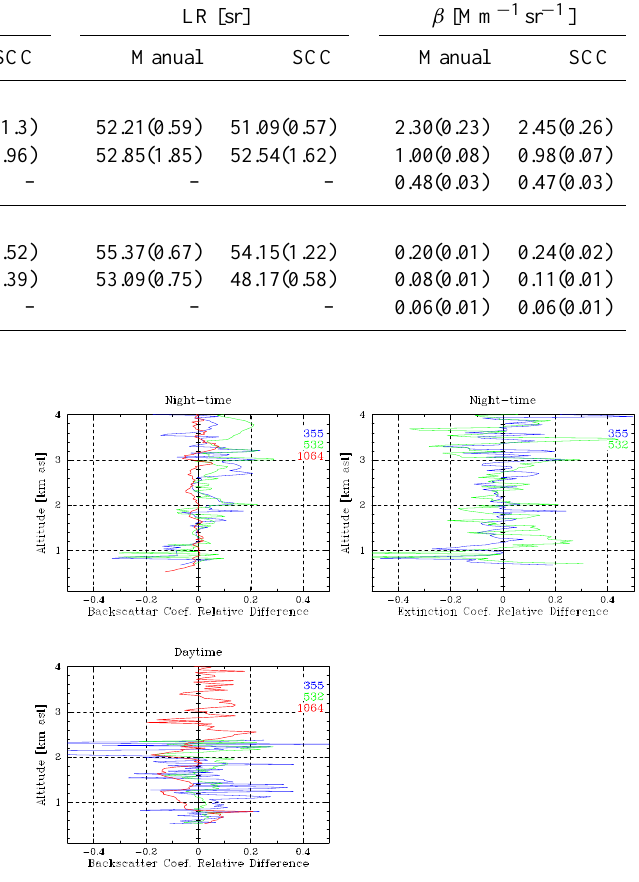
Figure 14. Relative differences between SCC and corresponding manually retrieved mean profiles for the Leipzig station (Polly XT system). On the left (upper part) the deviation between night- time mean aerosol backscatter profiles at 355, 532, and 1064nm (see Fig. 12) are shown. On the right (upper panel) the deviations between night-time mean aerosol extinction profiles at 355 and 532nm (see Fig. 12) are reported. In the bottom part the deviation between daytime mean aerosol backscatter profiles at 355, 532, and 1064nm (see Fig. 13) are